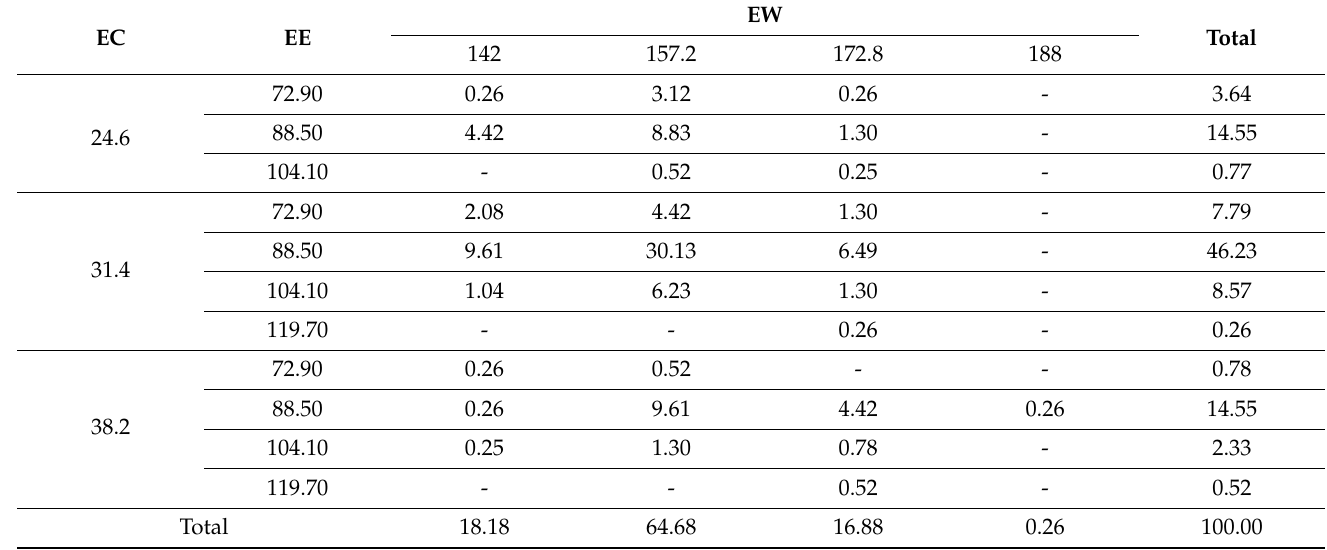
Table 5. Cross-analysis results of the representative dimensions of sections (%).